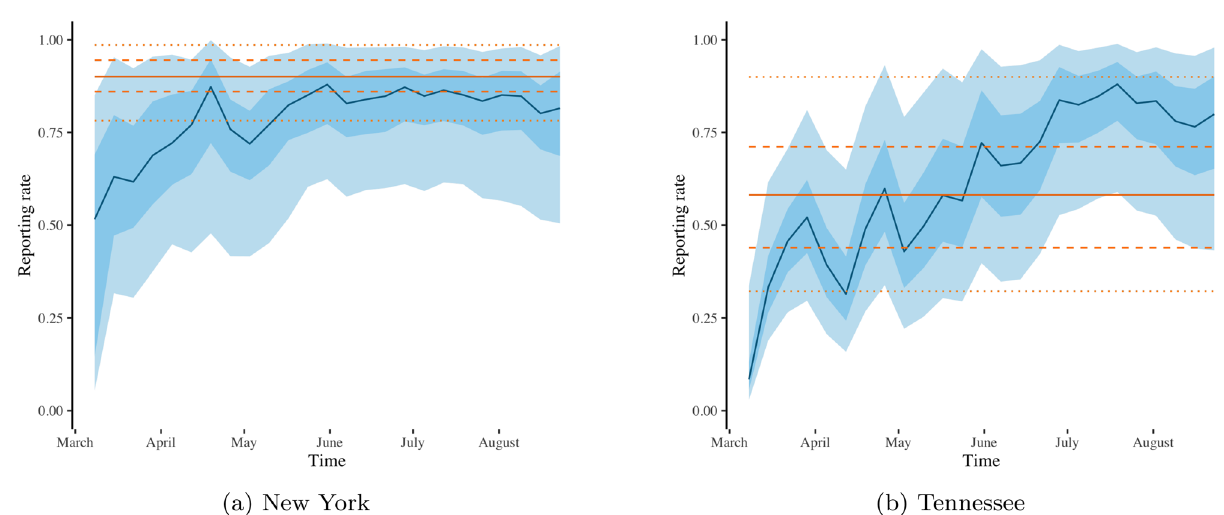
Figure 8. Estimates of the COVID-19 reporting rate for New York ( a ) and for Tennessee ( b ) obtained from the SEIR model with constant (orange) and with time-varying (blue) reporting rate. The blue line, light-shaded and dark-shaded blue areas represent the respective posterior mean, 75% and 95% credible intervals of the time- varying reporting rate. The orange solid, orange dashed and orange dotted line represent the respective posterior mean, 75% and 95% credible intervals of the constant reporting